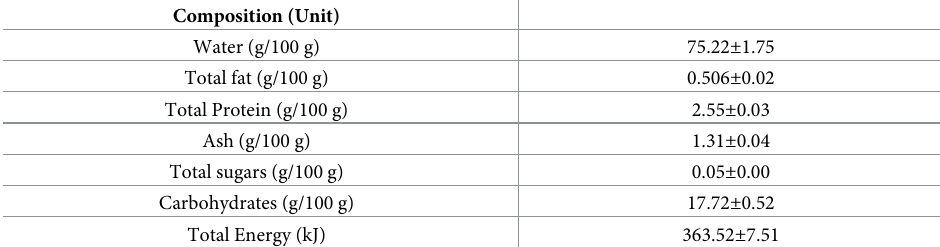
Table 1. Proximate nutritional composition of fresh Berberis heteropoda